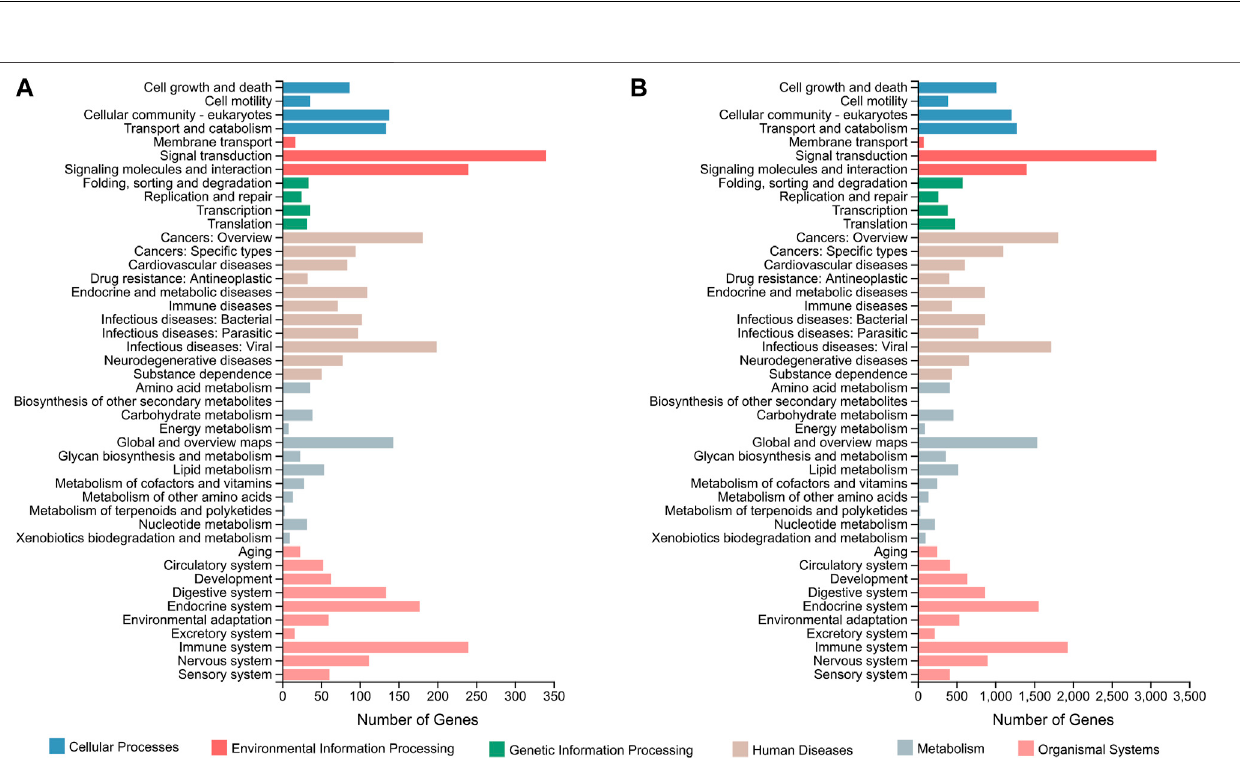
FIGURE2| KEGGclassi fi cationbasedontheDEGsoftheF_brain-vs-M_braingroup (A) andtheF_sex-vs-M_sexgroup (B) .Thehorizontalaxisshowsthenumber of DEGs enriched in each KEGG term. KEGG, Kyoto Encyclopedia of Genes and Genomes; DEG, differentially expressed gene.